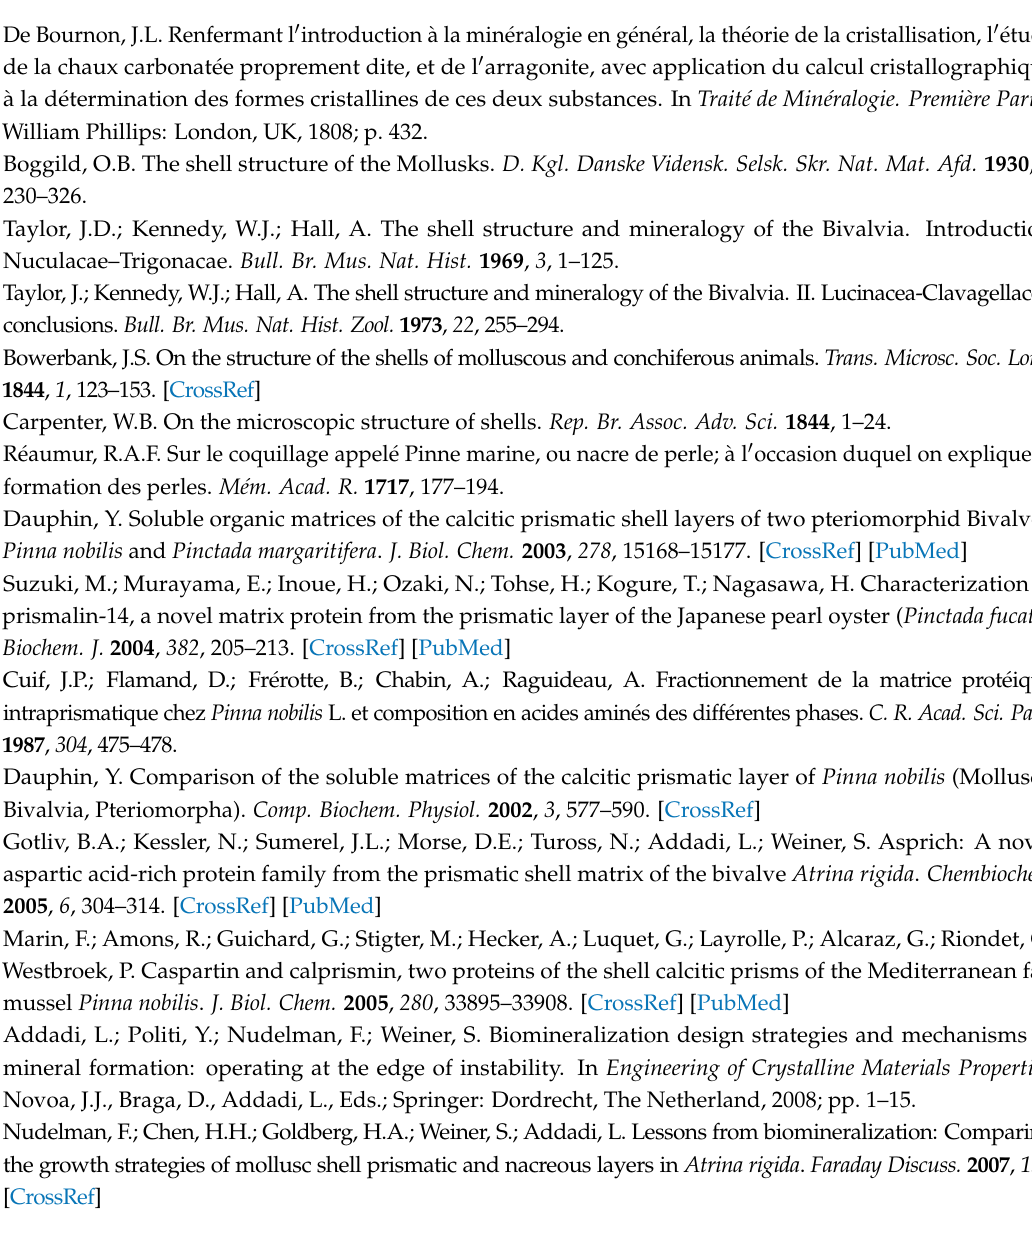
Figure S1: TGA profiles of organic molecules used as standards, Figure S2: Elemental chemical composition of the prisms of Pinna